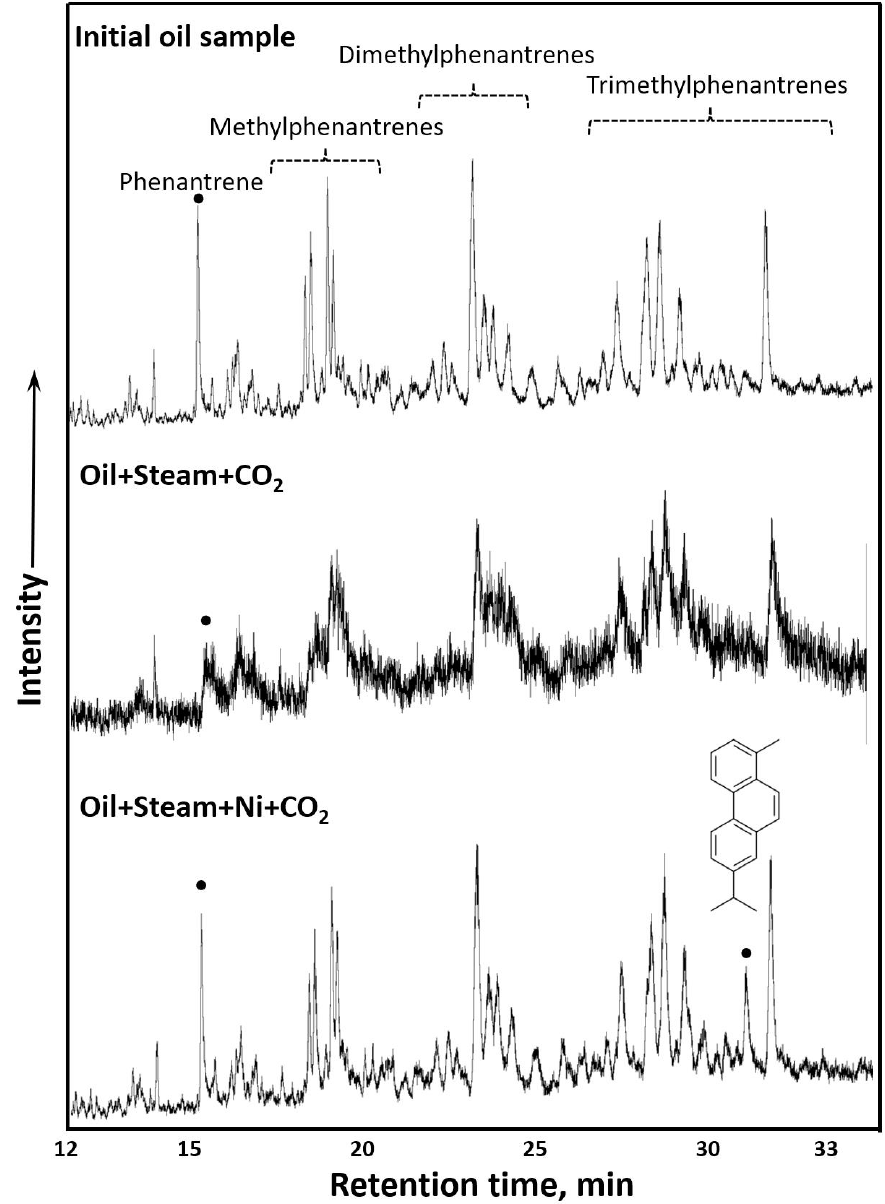
Figure 8. GC-MS spectra of phenanthrenes. Table 3. FTIR spectral coefficients of oil samples, before and after noncatalytic and catalytic hy- drothermal